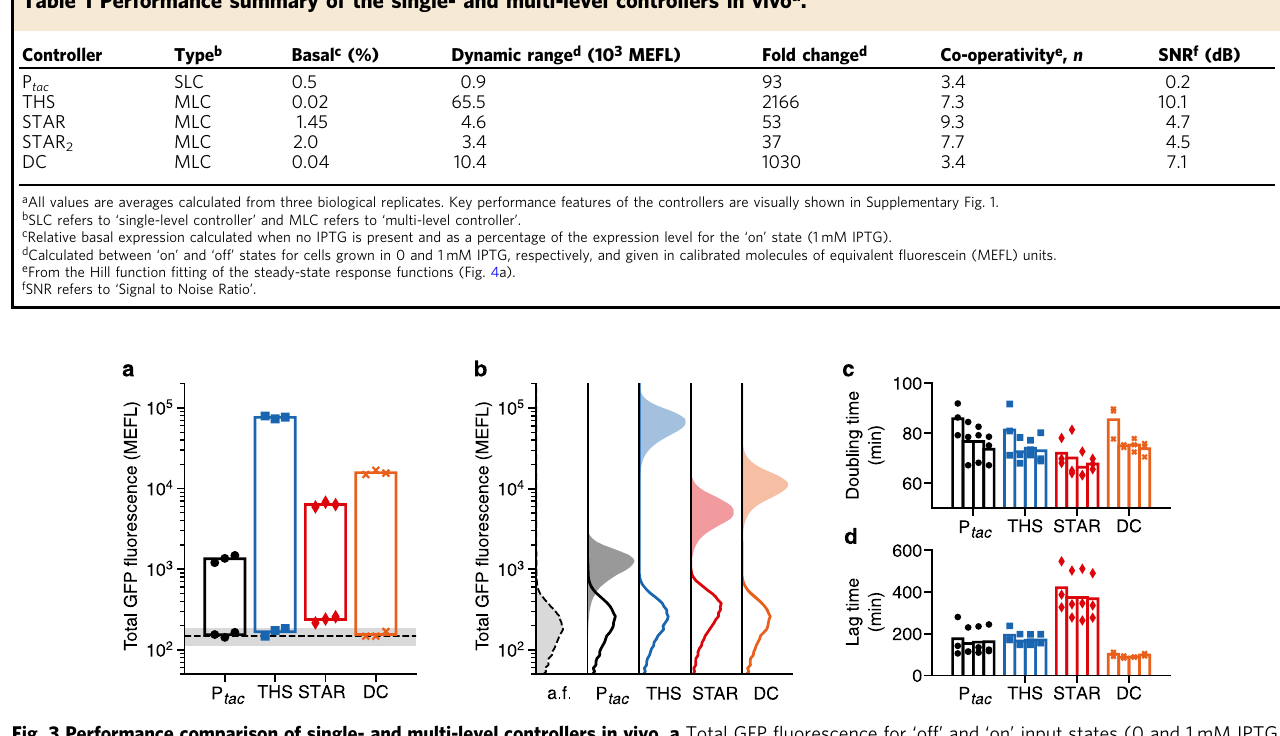
Fig. 3 Performance comparison of single- and multi-level controllers in vivo. a Total GFP fl uorescence for ‘ off ’ and ‘ on ’ input states (0 and 1 mM IPTG, respectively). Points show the three biological replicates for each controller and condition (black circles, P tac ; blue squares, THS; red diamonds, STAR; orange crosses, DC). Black dashed line denotes the mean fl uorescence of cell auto fl uorescence (a.f.) controls containing no plasmid with grey shaded region showing ±1 standard deviation of 11 biological replicates. Fluorescence given in calibrated molecules of equivalent fl uorescein (MEFL) units. b Flow cytometry distributions of total GFP fl uorescence for ‘ off ’ (line) and ‘ on ’ (shaded) input states. Cell auto fl uorescence (a.f.) controls containing no controller are shown by black dashed line and light grey fi lled distributions. c Doubling time of cells harbouring direct and multi-level controllers for varying concentrations of IPTG (bars left to right for each design: 0, 0.1, 1, 10 mM IPTG). d Lag time calculated as the time to reach an OD 600 = 0.15 after inoculation of cells harbouring controllers for varying concentrations of IPTG (bars left to right for each design: 0, 0.1, 1, 10 mM IPTG). Source data are provided as a Source Data fi le.